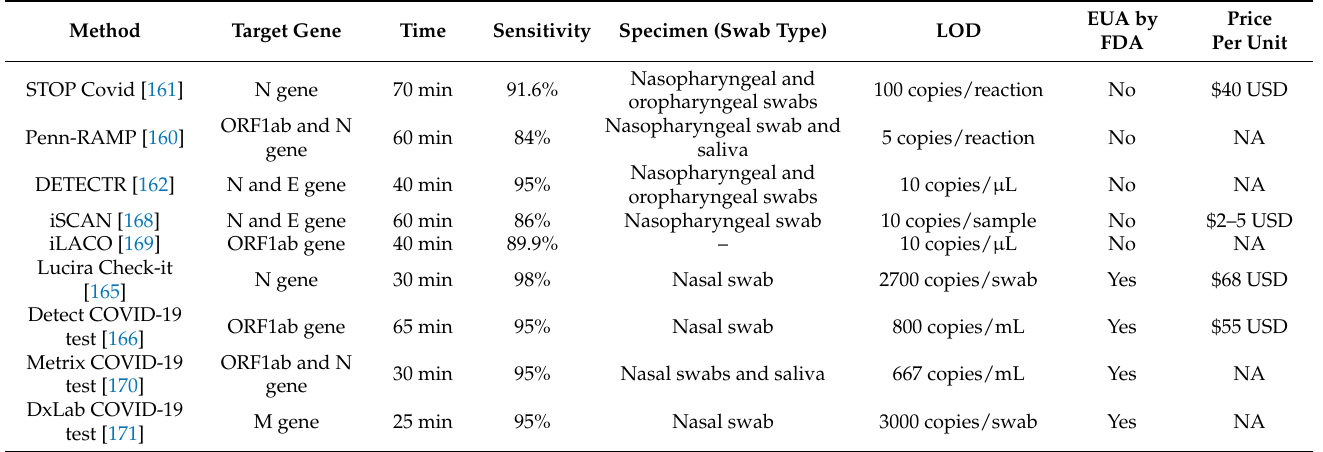
Table 5. RT-LAMP-based methods for COVID-19